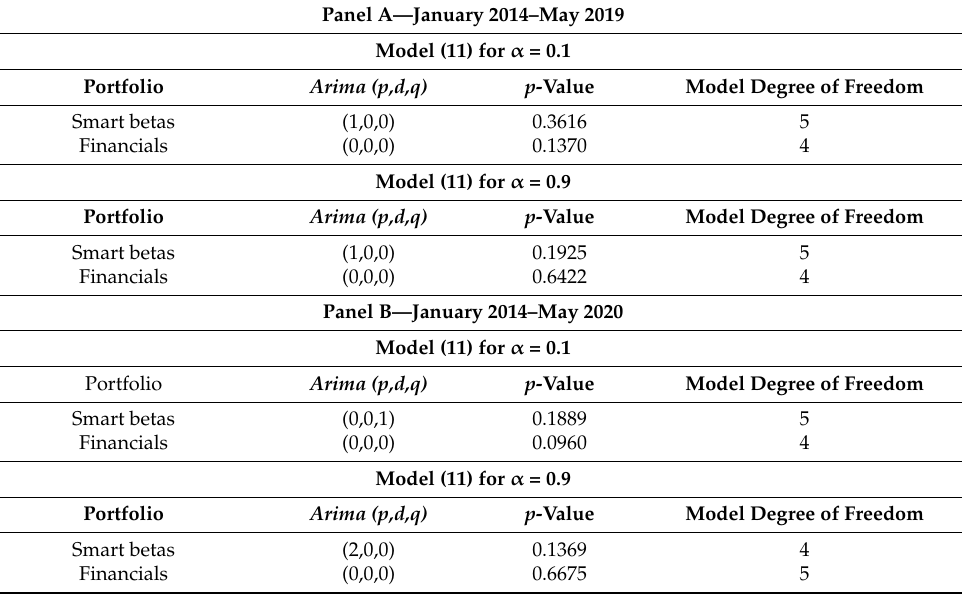
Table A2. Details on the results of auto.arima() corresponding to model (11)–(12) in Table